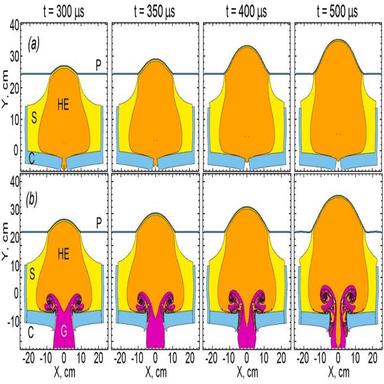
CTH calculation of the target plate deformation subjected to sand ejecta for the configuration U, ρ0 = 1.31 g/cm3 (a) and V, ρ0 = 1.33 g/cm3 (b) validation tests with the as-received dry calcite sand.